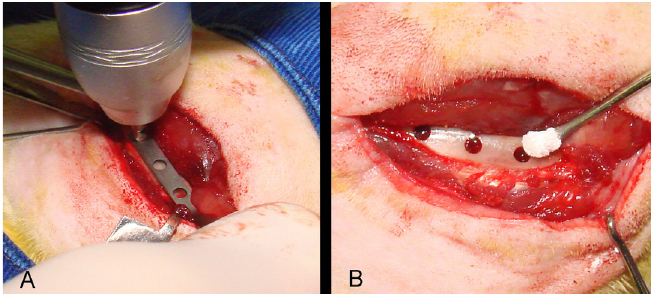
FIGURE 1 – ( A ) Positioning the trephine drill guided by the surgical guide. ( B ) Image illustrating the moment of calcium phosphate cement insertion into the produced